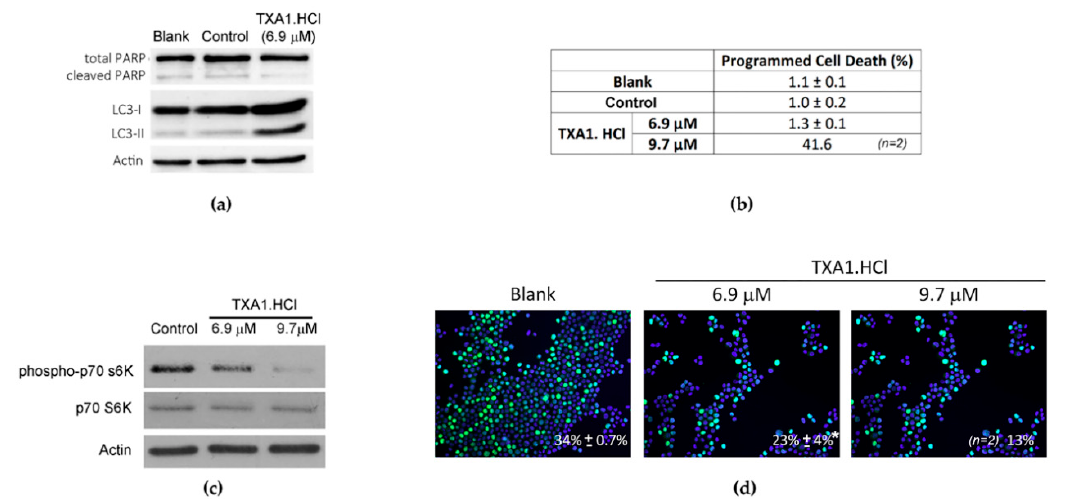
Figure 8. TXA1.HCl treatment induced autophagy. NCI-H460 cells were treated with 6.9 µ M or with 9.7 µ M TXA1.HCl for 48 h or with the solvent control (H 2 O). ( a ) PARP-1 and LC3 levels were analyzed by Western blot. Actin was used as loading control. ( b ) Programmed cell death was assessed with the TUNEL assay. ( c ) Levels of p70 s6K protein and of the phosphorylated form were analyzed by Western blot. Actin was used as a loading control. ( d ) Cellular proliferation was evaluated with the BrdU incorporation assay followed by fluorescence microscopy. In blue, Dapi stained nuclei. In green, BrdU incorporating nuclei. Values in the images correspond to the % of proliferating cells, expressed as mean ± SEM (* p < 0.05 vs. control). Results (and representative images) are from at least 3 independent experiments, except when otherwise stated (which were from 2 experiments